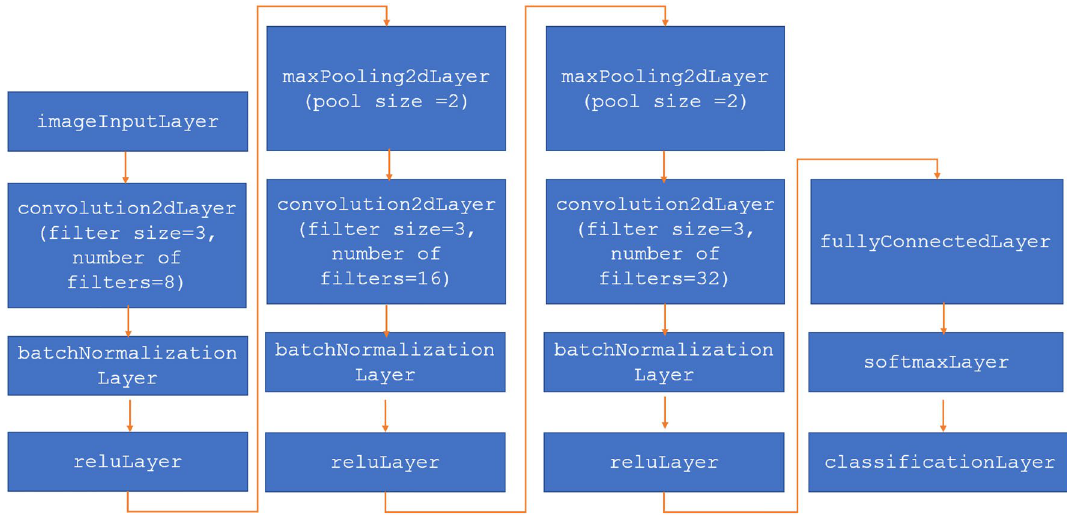
Figure 10. Complete architecture of the network used. An architecture consists of imageInputLayer, 2 × convolution2dLayer, 3 × batchNormaliza-tionLayer, 3 × reluLayer, 2 × maxPooling2dLayer, fullyConnected-Layer, softmaxLayer and